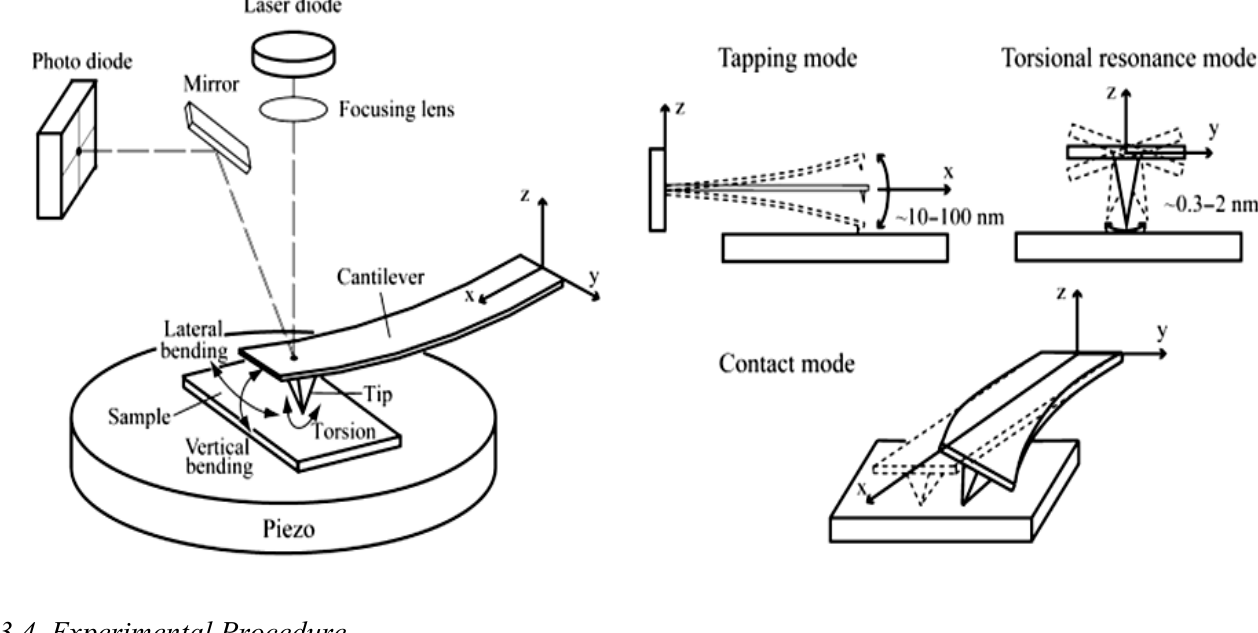
Figure 6. Atomic Force Microscopy. Schematic diagram of AFM and three different AFM operating modes. In this paper Tapping and Contact Modes are